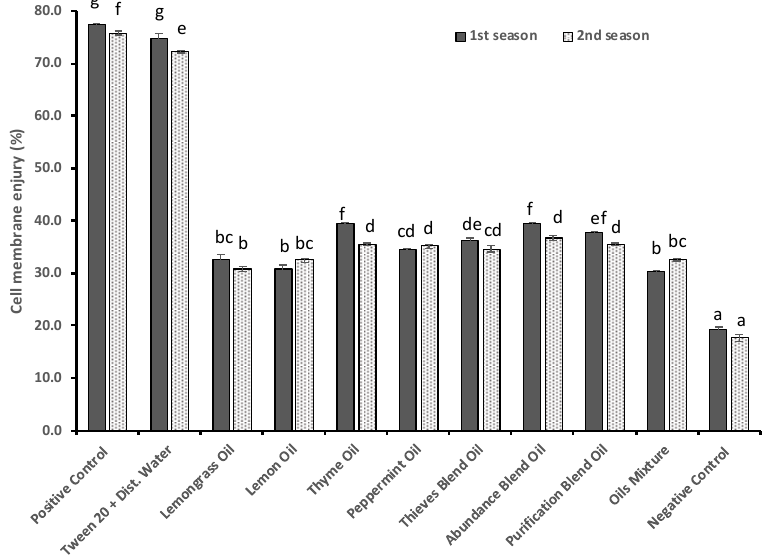
Figure 5. Effect of essential oils on the injury percentage of the cell membranes of cucumber leaves. Vertical bars represent the standard error ( n = 3). Columns in the same color and followed by different letter(s) are significantly different at p < 0.05.